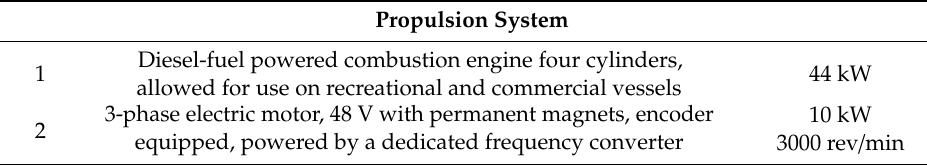
Table 2. Propulsion system data.